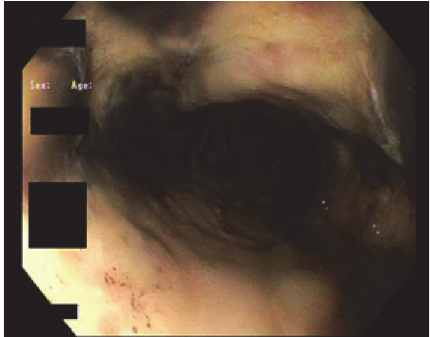
Figure 4: Follow-up endoscopic image (3 days after) of distal esophagus showing